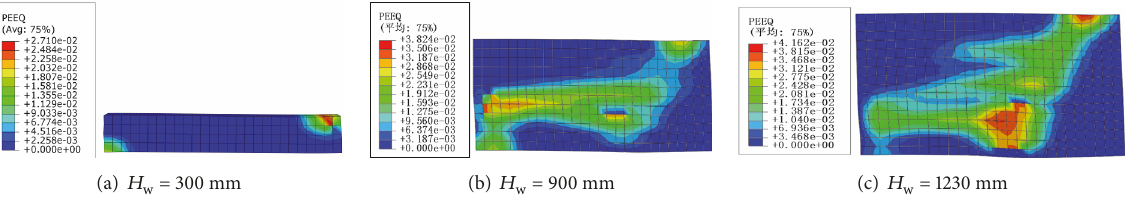
Figure 21: Plastic strain in infill walls ( 𝑓 m = 2MPa).